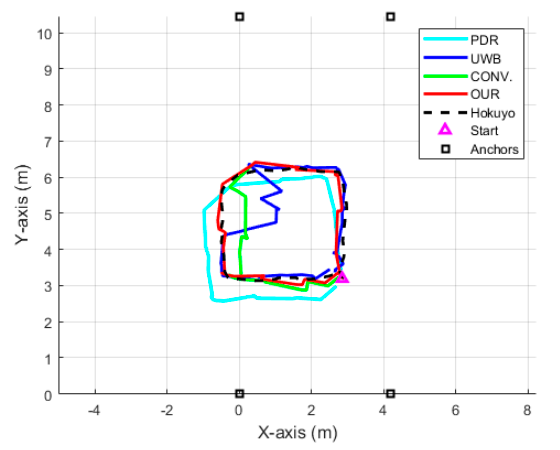
Figure 12. Position trajectory of each algorithm in single-lap NLOS scenario.